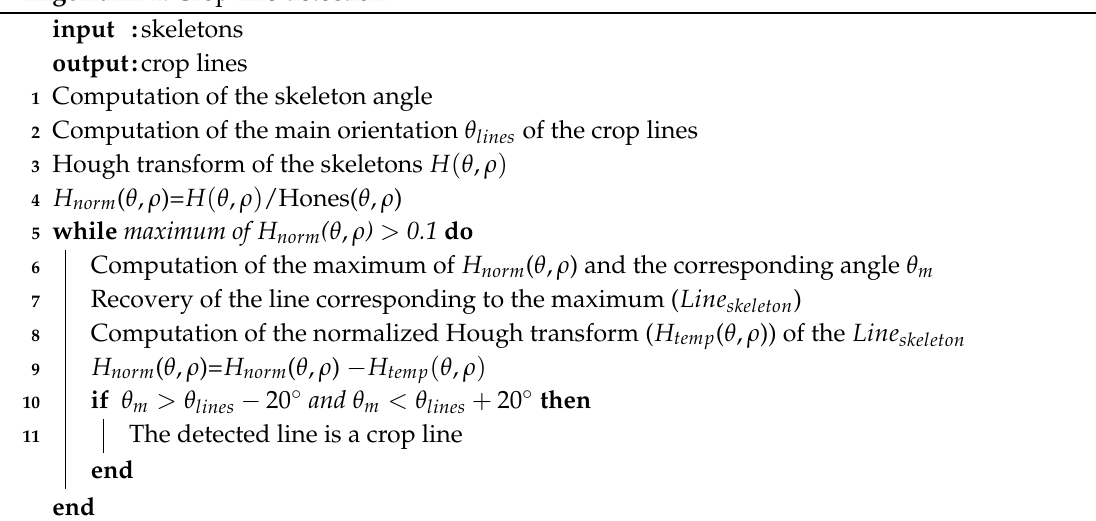
Figure 2. Flowchart of crop line detection method. Algorithm 1: Crop line